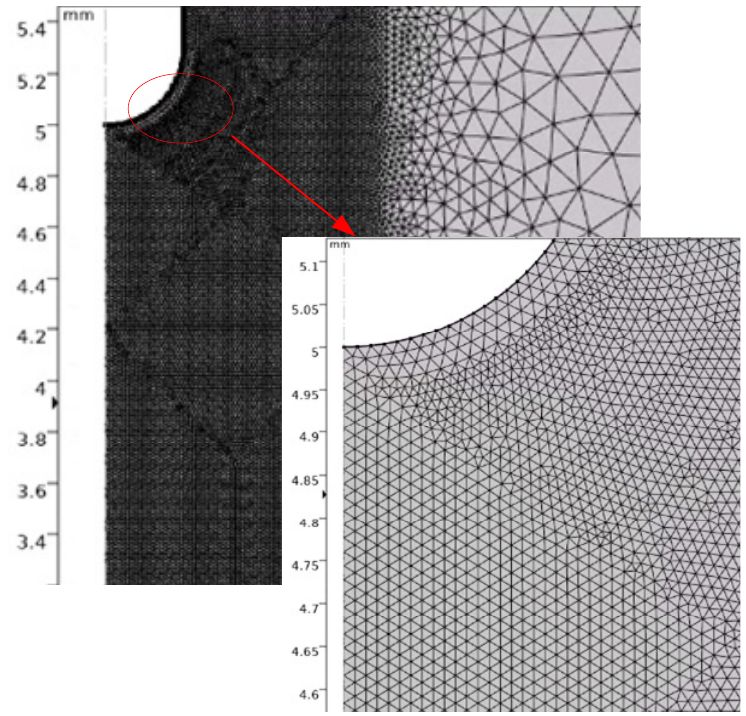
Figure 1. Partial mesh.